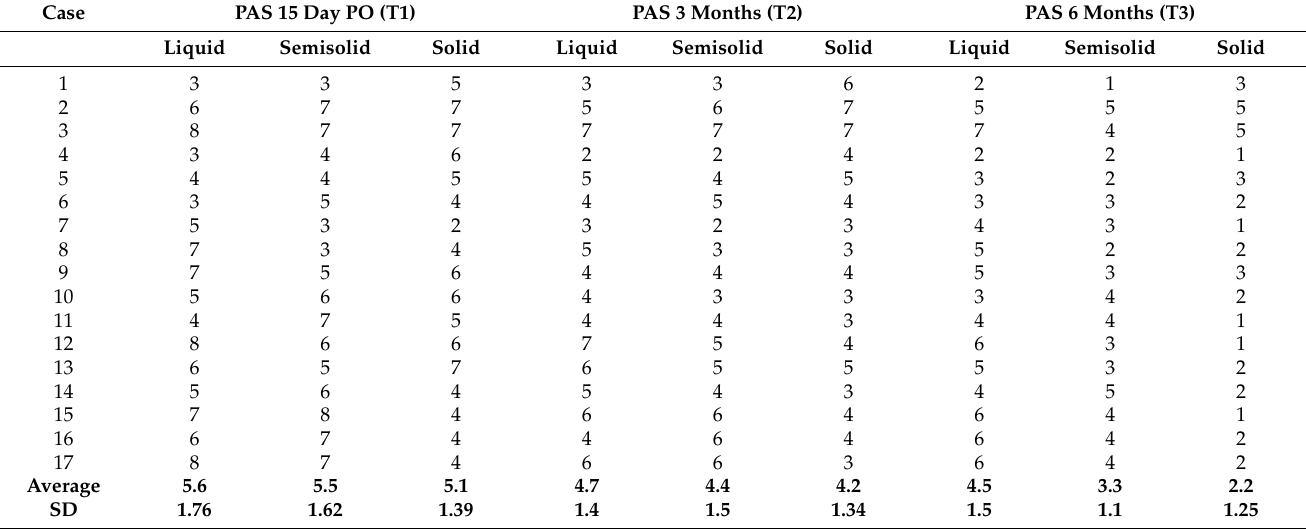
Table 3. OPHL-PAS evaluation during the rehabilitation protocol.